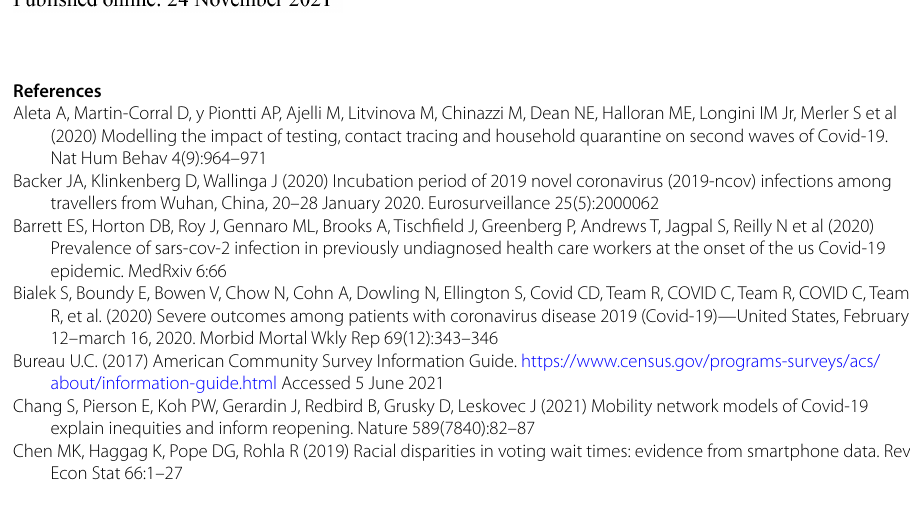
Figure 10 assumes an entirely susceptible population at t are fixed, testing is necessary to supplement quarantine measures.